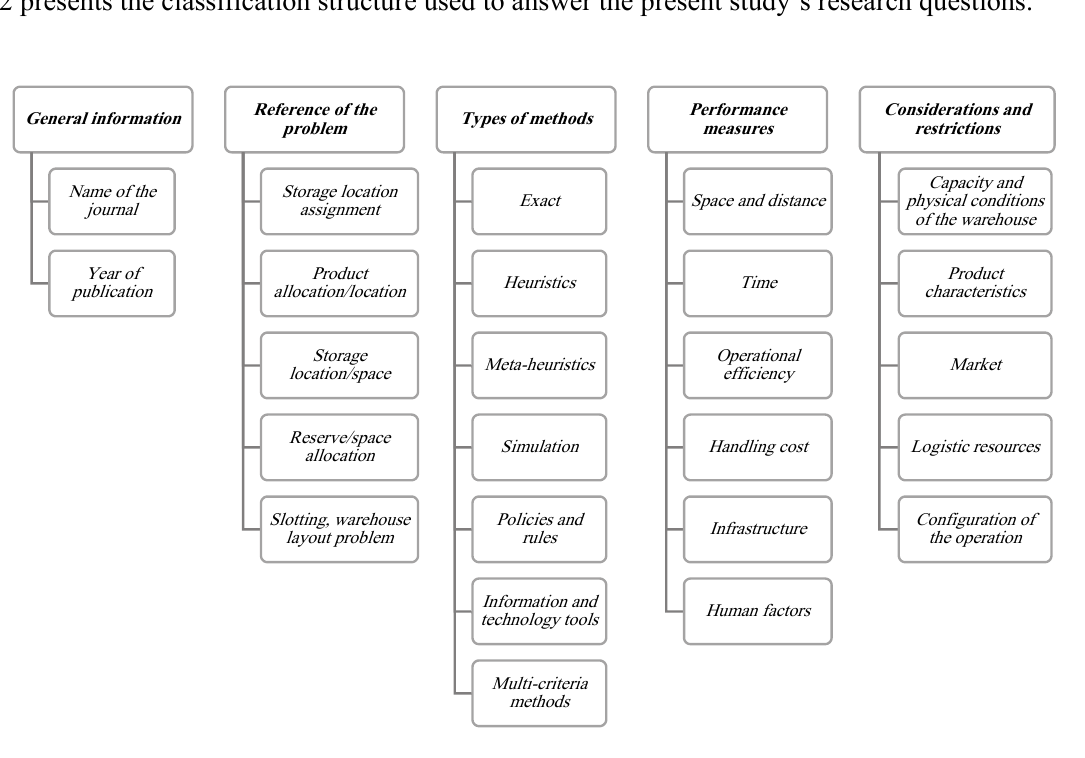
Fig. 2. Methodological structure of document